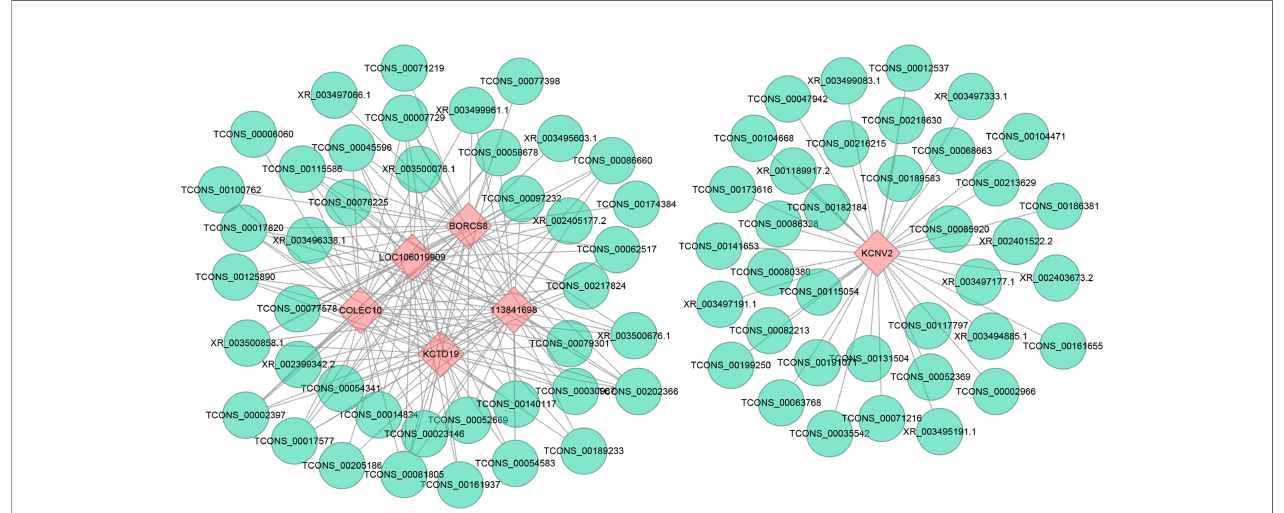
FIGURE 7 | Construction networks of the interaction between DELs and top 6 trans target genes with the largest connections. Blue nodes represent lncRNAs, and pink nodes represent target genes. The line between lncRNAs and target genes indicates an expression pattern correlation.